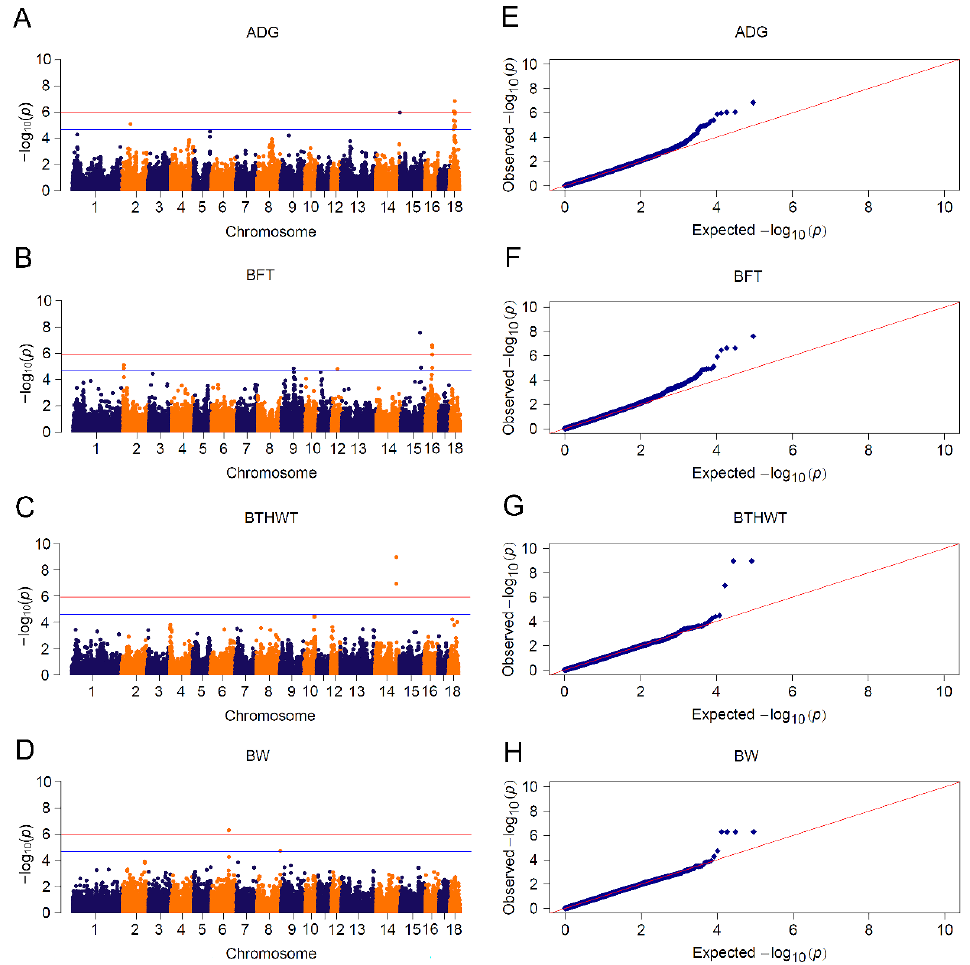
Figure 4. Meta-analyses for 4 growth traits. Manhattan plots for: ( A ) ADG: average daily gain; ( B ) BFT: backfat thickness; ( C ) BTHWT: birth weight and ( D ) BW: body weight. Q-Q plots for: ( E ) ADG, ( F ) BFT, ( G ) BTHWT and ( H ) BW. The red and blue lines in plots represent genome-wide and sug- gestive significance thresholds, respectively.